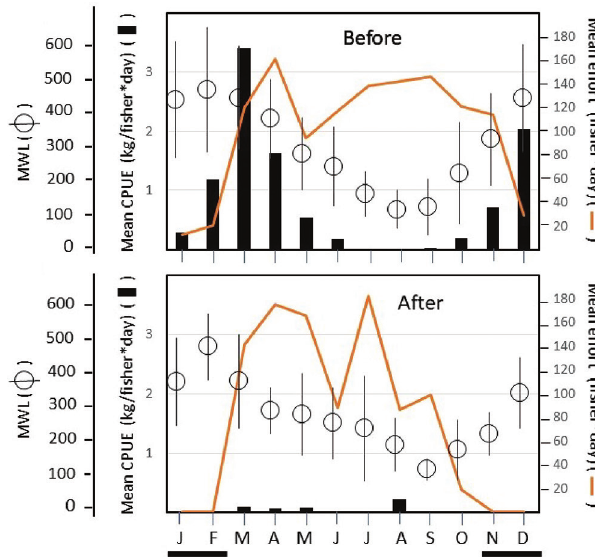
Fig. 3. Mean annual fishing effort and capture per unit effort (CPUE) of Brachyplatystoma rousseauxii (black bars) per month in the Ichilo River before (1998–2007) and after dam closure (2015–2017) using catfish-specific fishing methods. Mean monthly water level (MWL) in Puerto Villarroel for the two sample periods is shown (SENAMHI 2018), with vertical lines representing standard deviation. The horizontal bars show the period when commercial fishing is prohibited.